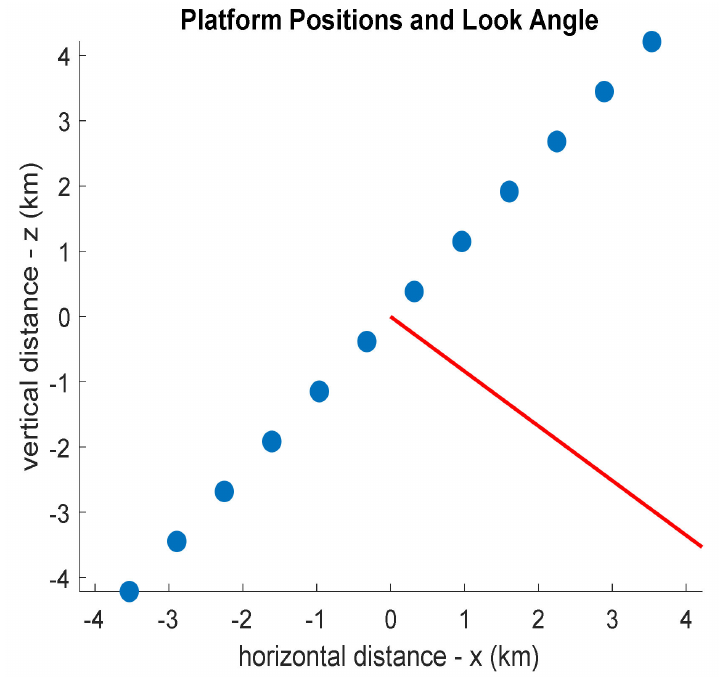
Figure 27. The observation geometry for Example 6. Blue dots represent the platform locations and the red line represents the look angle.